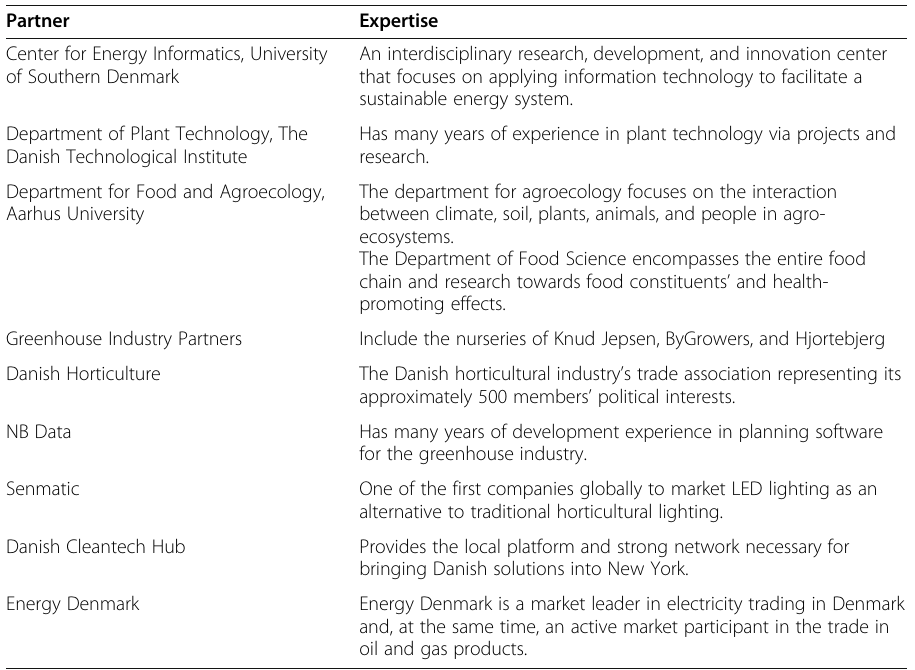
Table 1 GHI4.0 project partners